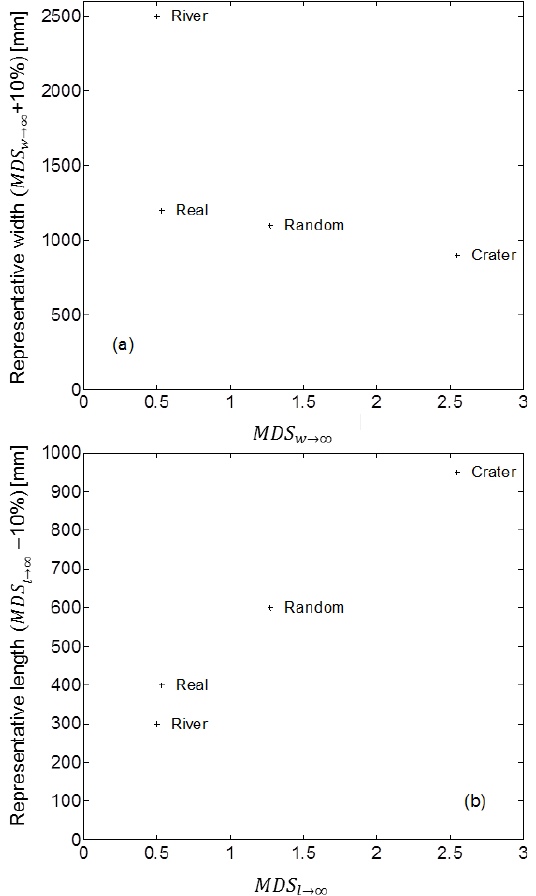
Fig. 14. (a) Representative width as a function of the MDS value for w → ∞ for the four microtopography types and (b) representa- tive length as a function of the MDS value for l → ∞ for the four microtopography